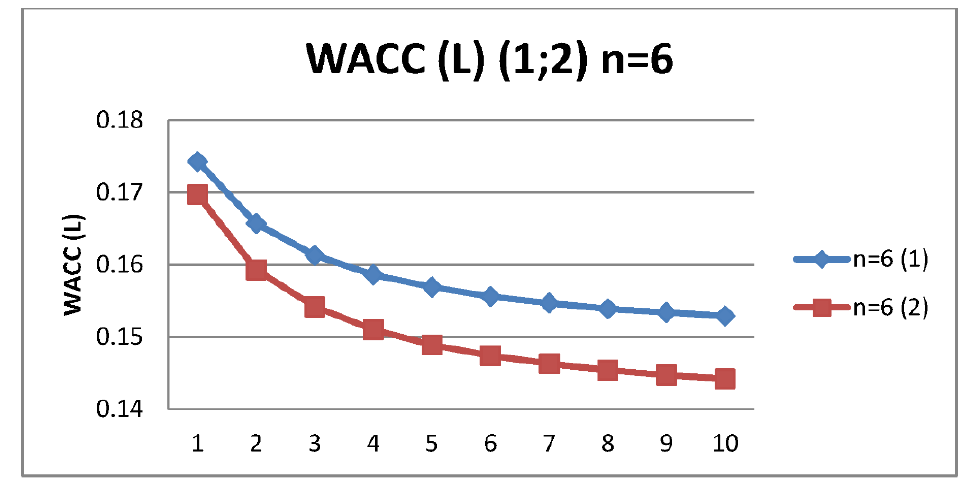
Figure 4. Dependence of the weighted average cost of capital, WACC , on leverage level L in the cases of payments of tax on profit at the end of the year (1) and in the beginning of the year (2) for six-year company.